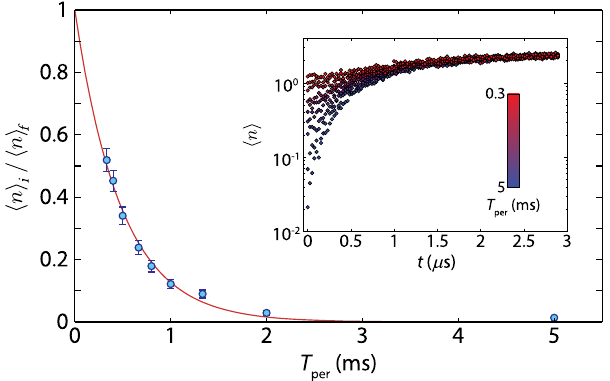
= h n i versus i f . per